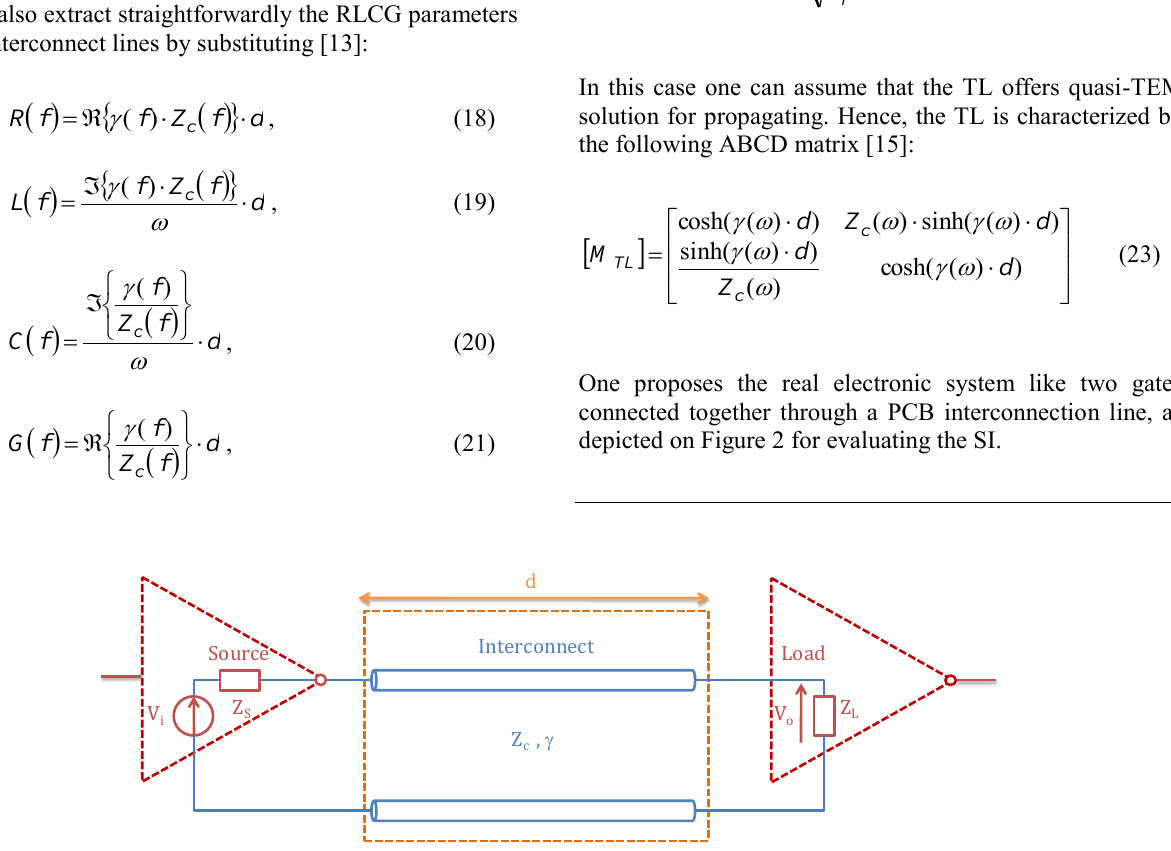
Figure 2: Circuit diagram representing interconnect line driven by source gate with impedance Z S and loaded by input impedance Z L